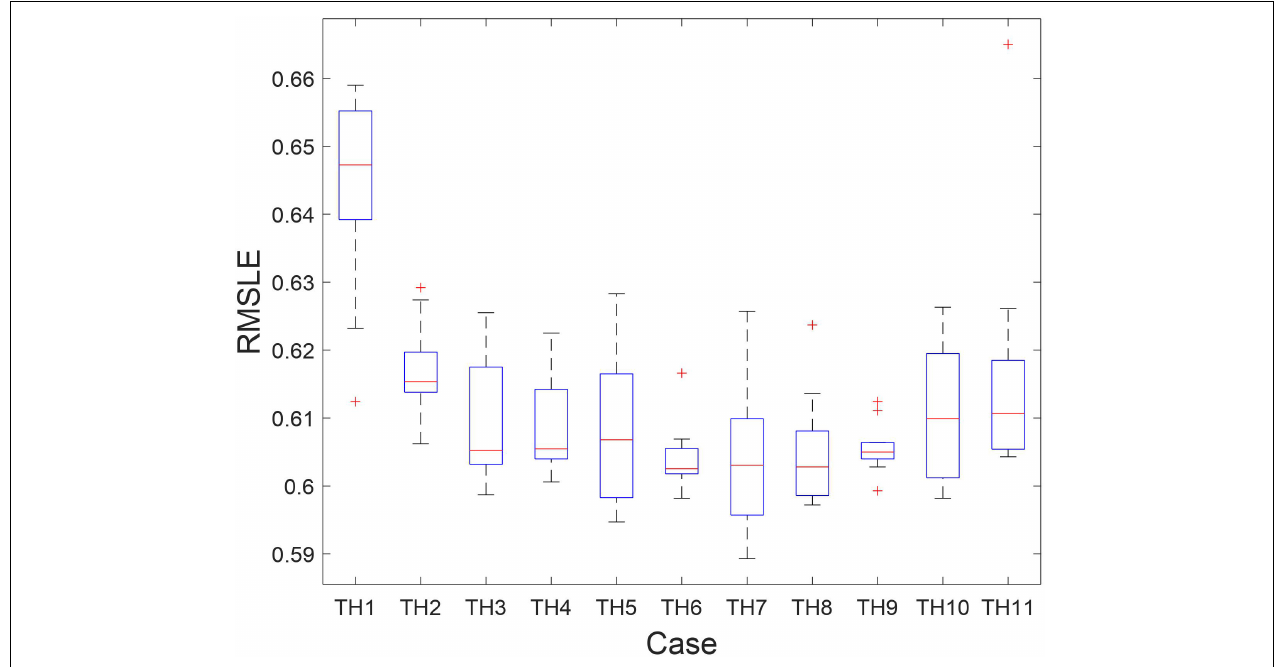
FIGURE 3 | The box plots of the RMSLE of the Cases TH1 to TH11 (using raw values of time history data).